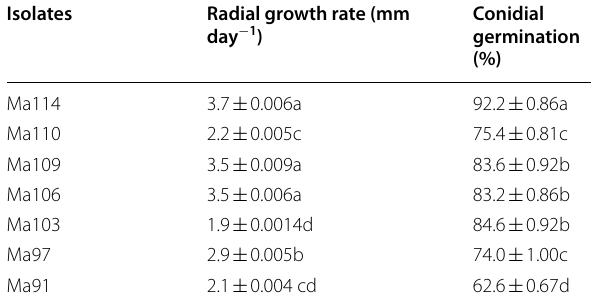
Different letters indicate significant differences between all Metarhizium strains. ANOVA and Tukey test ( p 0.05) ≤